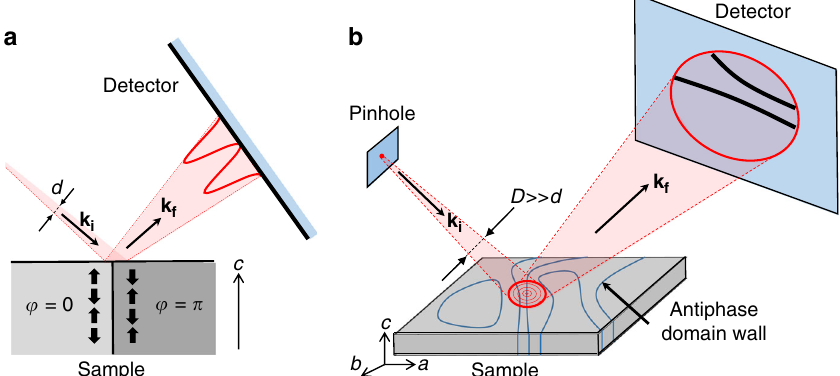
Fig. 1 Schematic experimental setup. a Diffraction of a small beam off an antiphase magnetic boundary. Black solid arrows indicate the effective magnetic order probed in our experiment, φ is the phase of the magnetic order parameter, k i and k f are the incident and outgoing wave vectors. A fringe pattern with a dark central line is produced on the area detector. b The full experimental setup, showing the large incident beam spot on the ab surface of the sample, and the image of the domain boundaries (dark lines) obtained on a remote area detector. Beam diameters D and d are explained in the